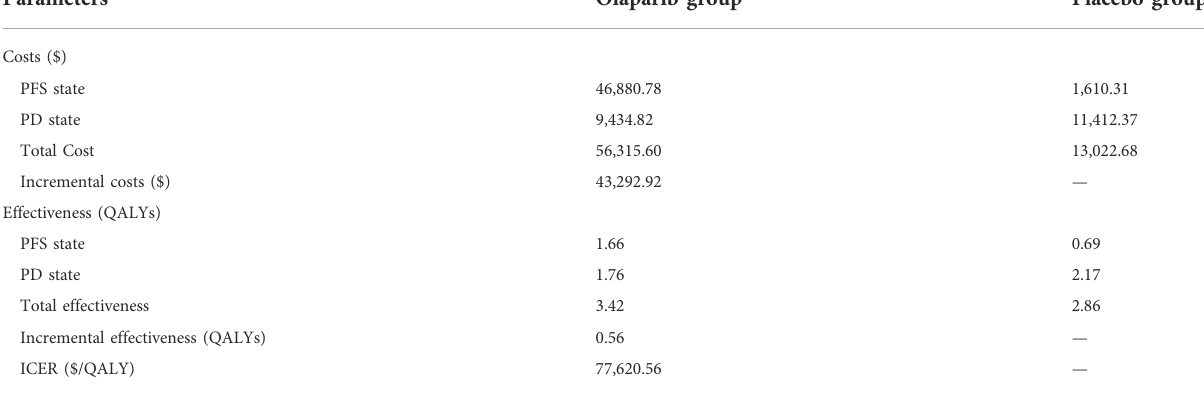
TABLE 3 Cost and outcome results of the cost-effectiveness analysis.